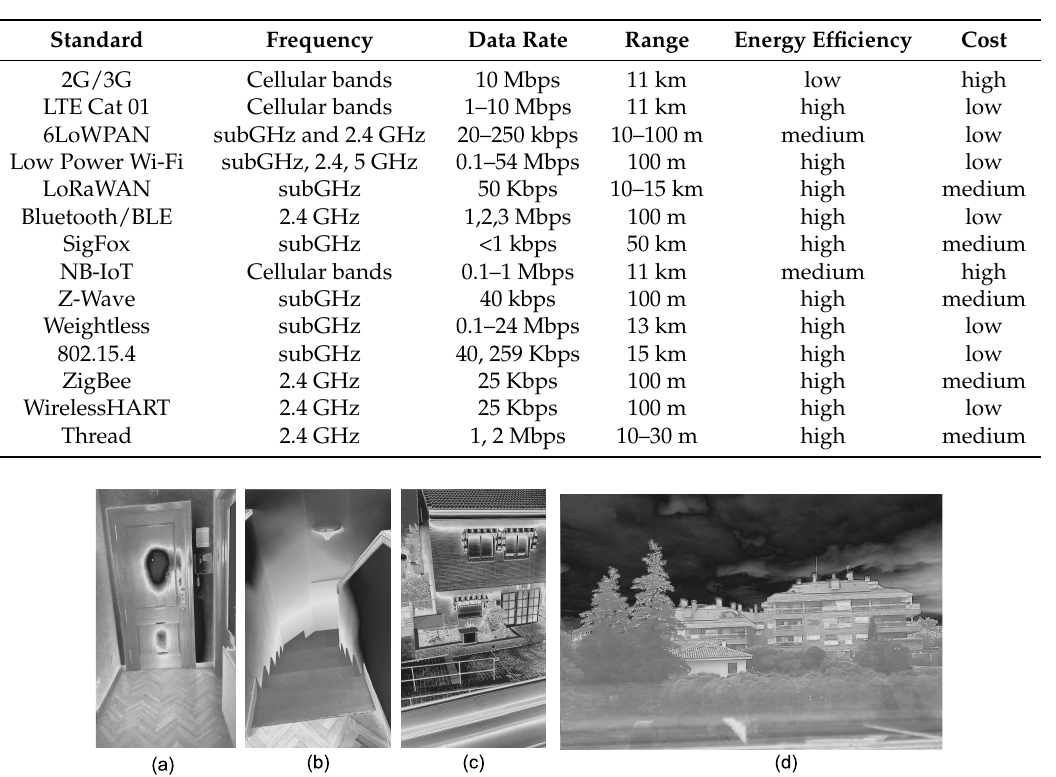
Table 3. Main features of the most extended wireless communications standards.